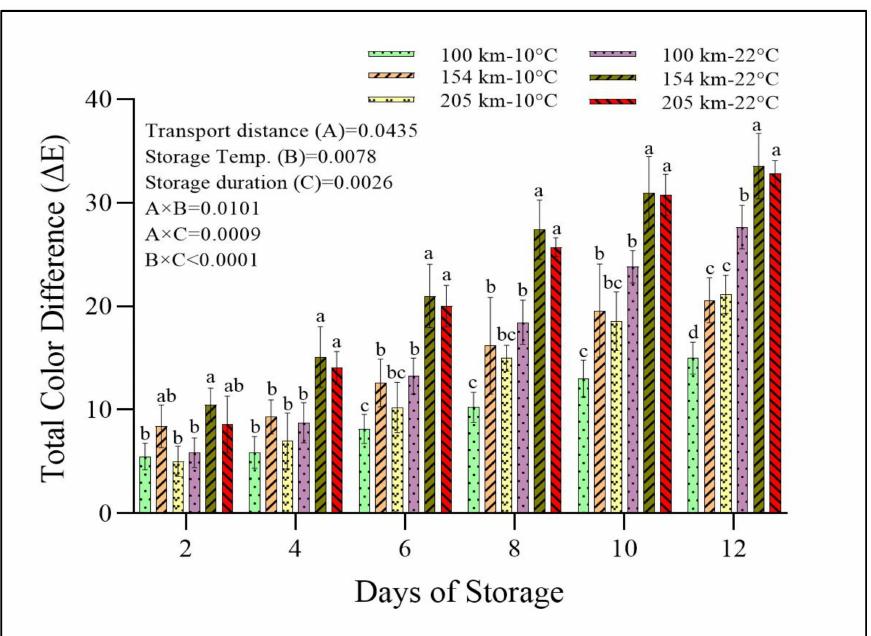
Figure 8. Total color differences ( ∆ E) value of tomatoes from three different distances stored at (A) 10 ± 0.5 ◦ C (95 ± 1% RH) and (B) 22 ± 1 ◦ C (65 ± 5% RH) for 12 days. Error bars represent standard error (SE) of the mean values ± S.E. of 25 measurements (readings) of 5 tomato replicates. Bars with different letters (per day) are significantly different ( p < 0.05) performed by the Tukey HSD test and numerical values of A, B, and C are p